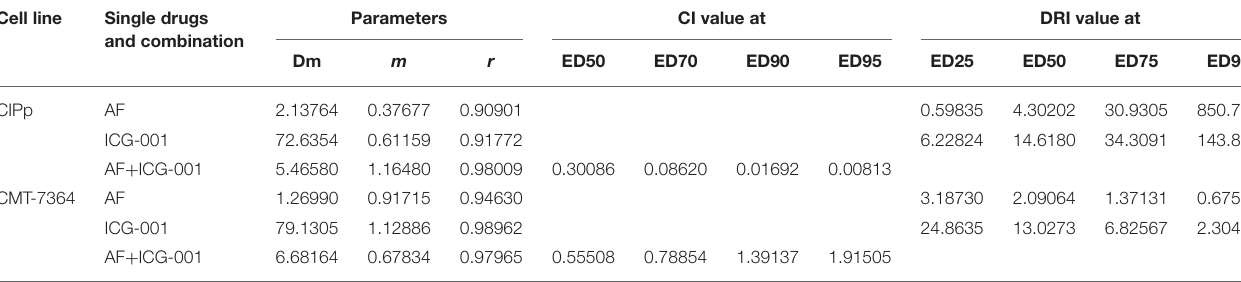
TABLE 1 | Dose-effect relationships of single drugs and combination in CBC cell lines. Cell line Single drugs and